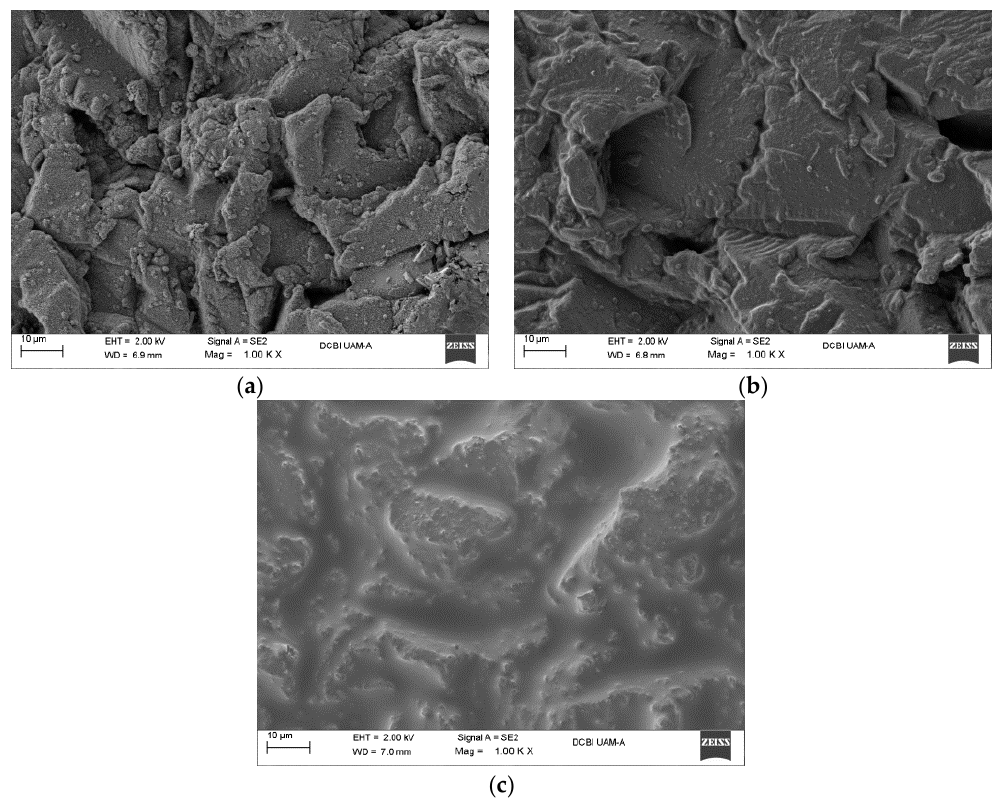
Figure 8. SEM micrographs of aluminum specimens after immersion in 3% hydrolyzed GPTMS solution at 25 ◦ C, at 1 K × , ( a ) 10 min; ( b ) 20 min; ( c ) 60